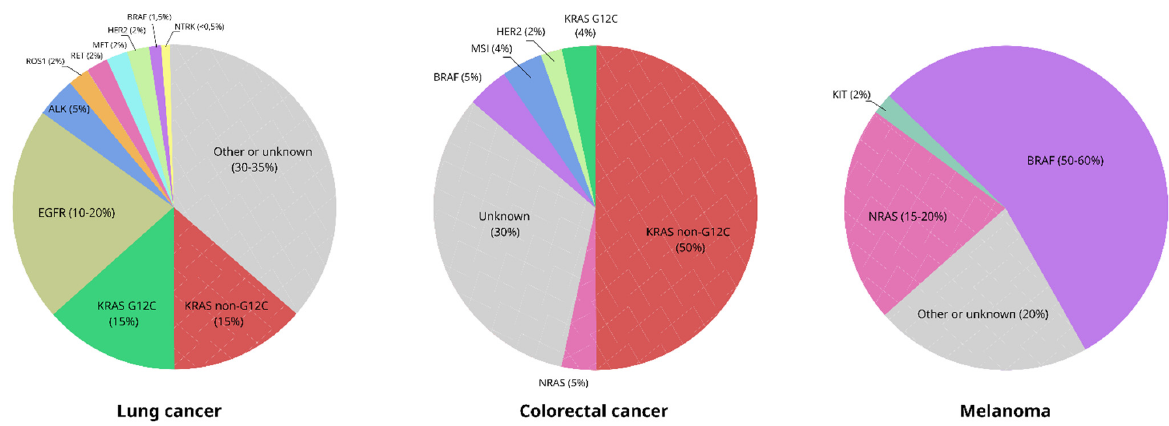
Figure 1. Spectrum of actionable mutations in lung carcinomas, colorectal cancers and skin melanomas.